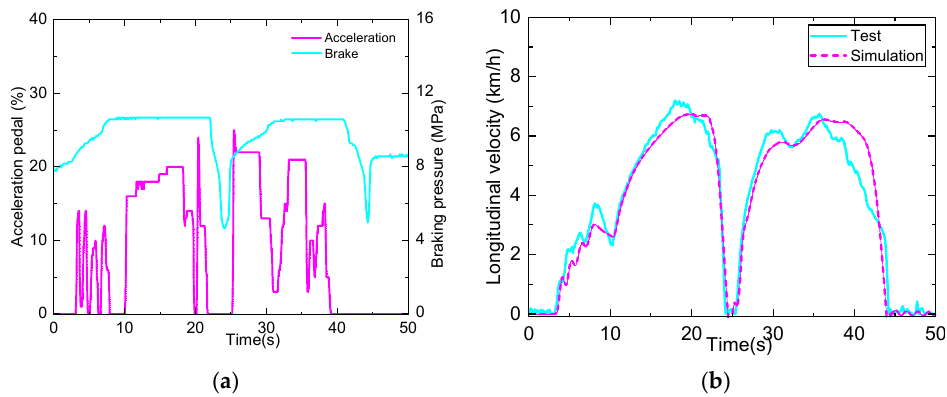
Figure 7. Longitudinal input and responses. ( a ) Input signal; ( b ) longitudinal velocity comparison results.